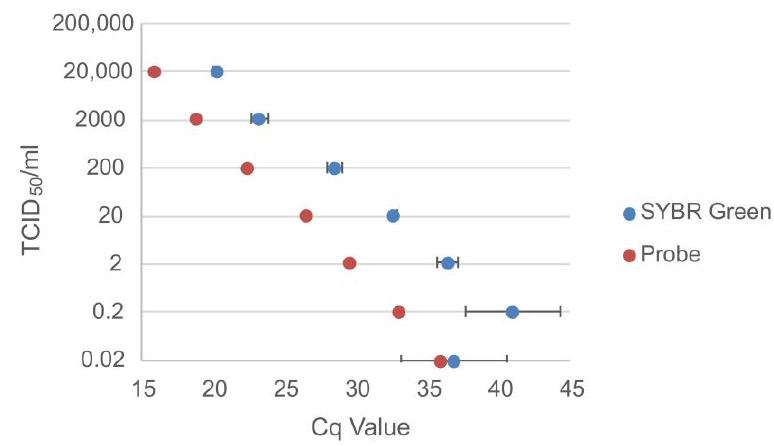
Figure 5. Comparison of the Cq values for the probe-based assay and the average Cq values for the